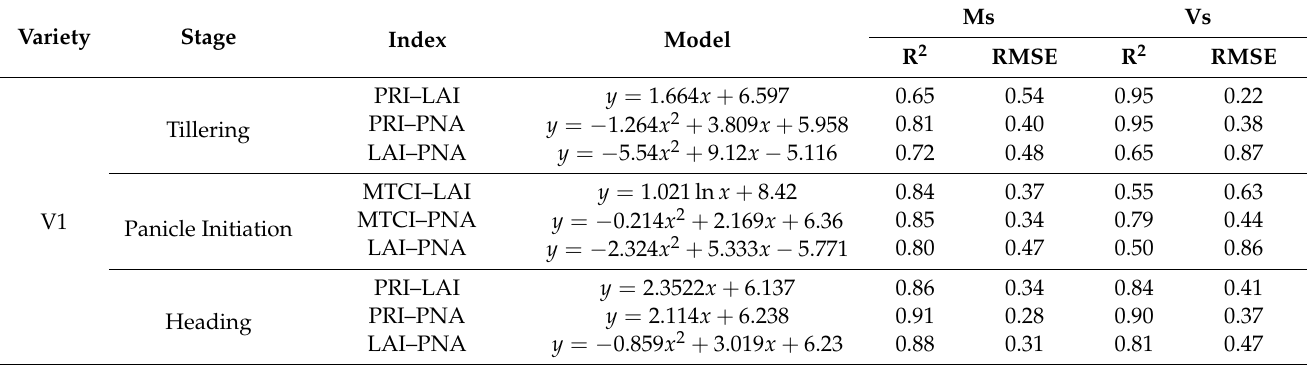
Table 9. Two-dimensional rice grain protein content (GPC) monitoring index models and their accuracy ( n =